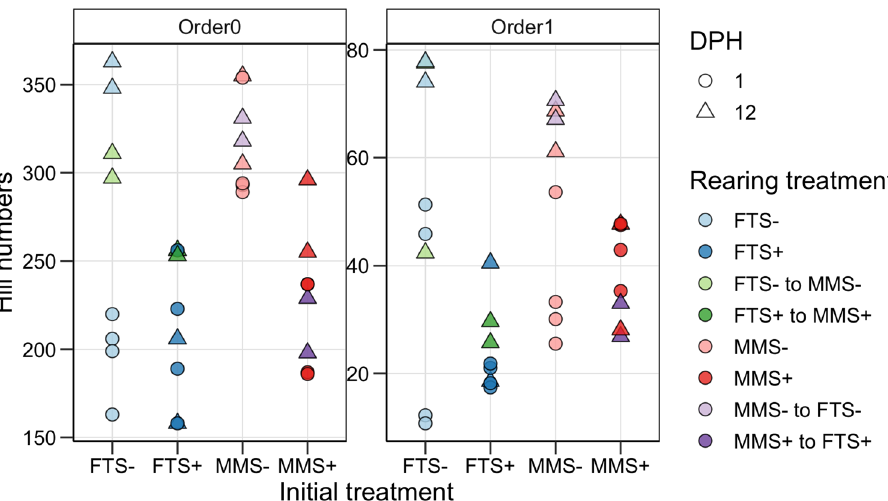
Figure 2. The bacterial α-diversity of Hill diversity orders 0 and 1 at 1- and 12-days post-hatching (DPH). Colours indicate rearing treatment, and shape signifies 1 (filled circle) and 12 DPH (filled triangle). Hill diversity of order 0 is equivalent to ASV richness, and order 1 is equal to exponential Shannon, which also accounts for ASV